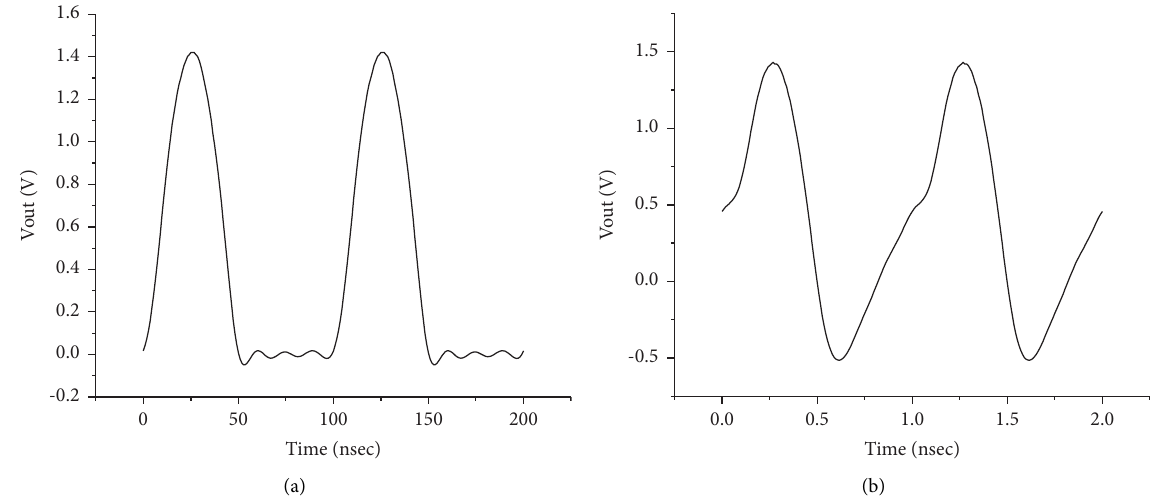
Figure 5: Output waveform on the load: (a) f 0 � 10 MHz and (b) f 0 � 1 GHz.